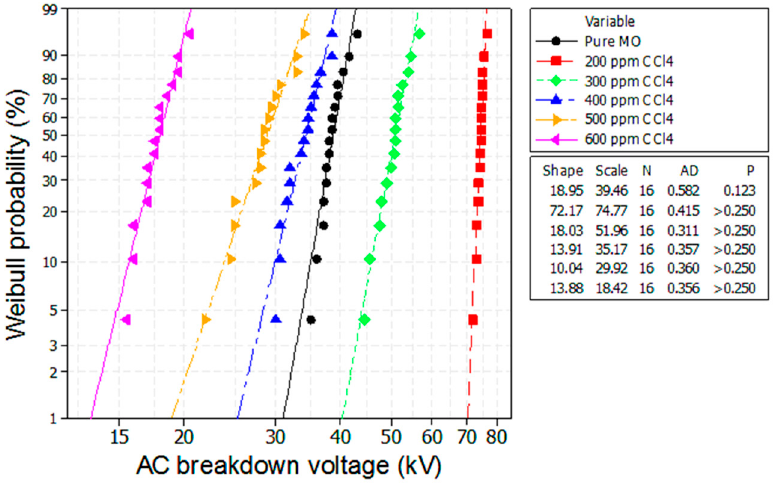
Figure 6. Weibull plot of the breakdown voltage of the mineral oil with various scavenger additives of CCl 4 .